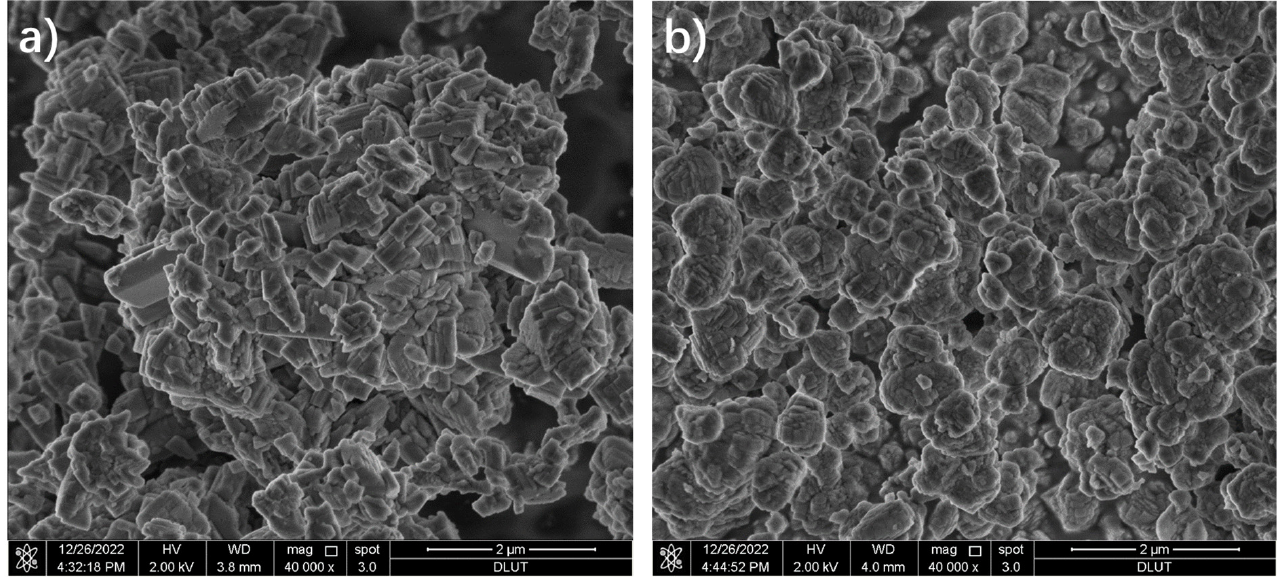
Figure 2. SEM images: ( a ) H-ZSM-5 SAR23; ( b ) H-ZSM-5 SAR80. The apparent activation energy was determined for H-ZSM-5 SAR80 with 1.10 bar